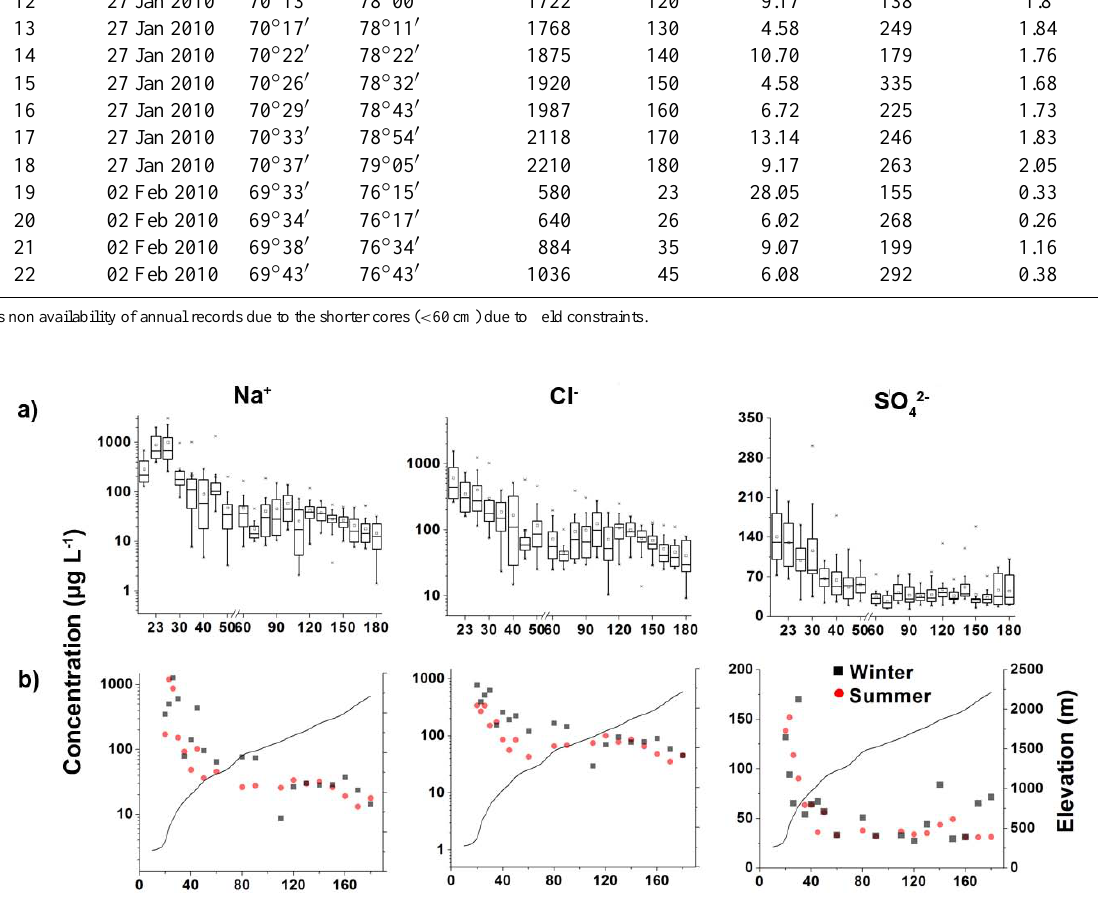
from coast to inland. Note the 4